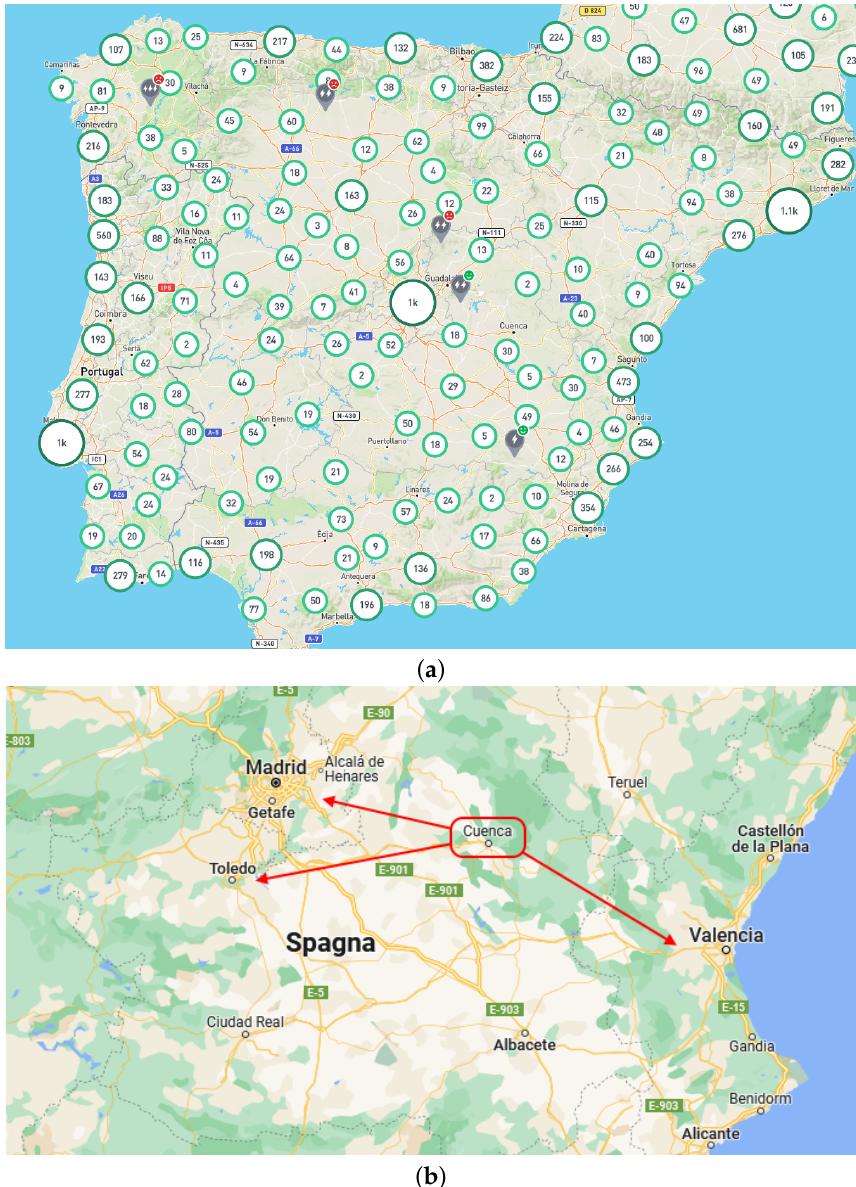
Figure 5. Locations of charging station infrastructures in Spain ( a ) and geographical location of Cuenca with the nearest cities in Spain ( b